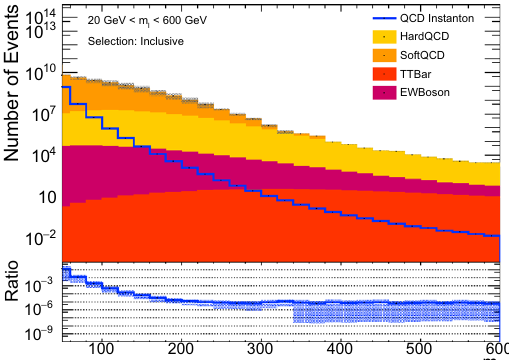
Fig. 7 Invariant mass distribution of all reconstructed tracks for stan- dard model background processes and Instanton processes (left) as well asthesamedistributionforeventswithatleasttenreconstructedparticle jets with a p T > 20 GeV (right). The events correspond to an integrated